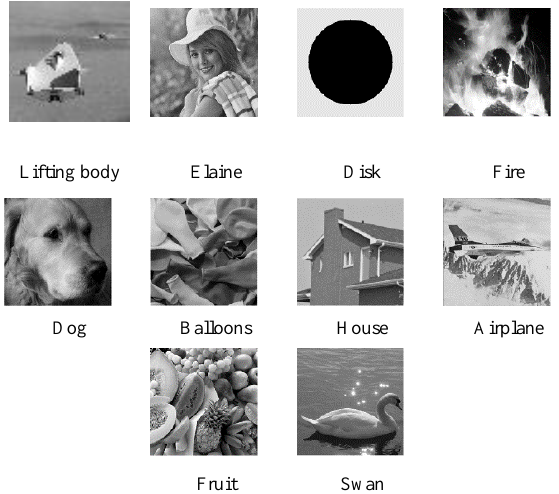
Figure 5. Different standard images for image zooming.